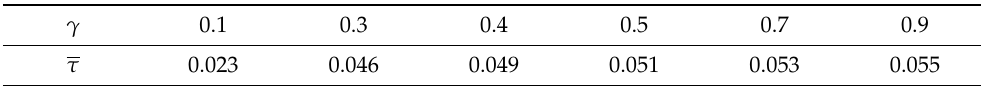
Table 3. Maximum allowable τ for various of γ values in Case 2.